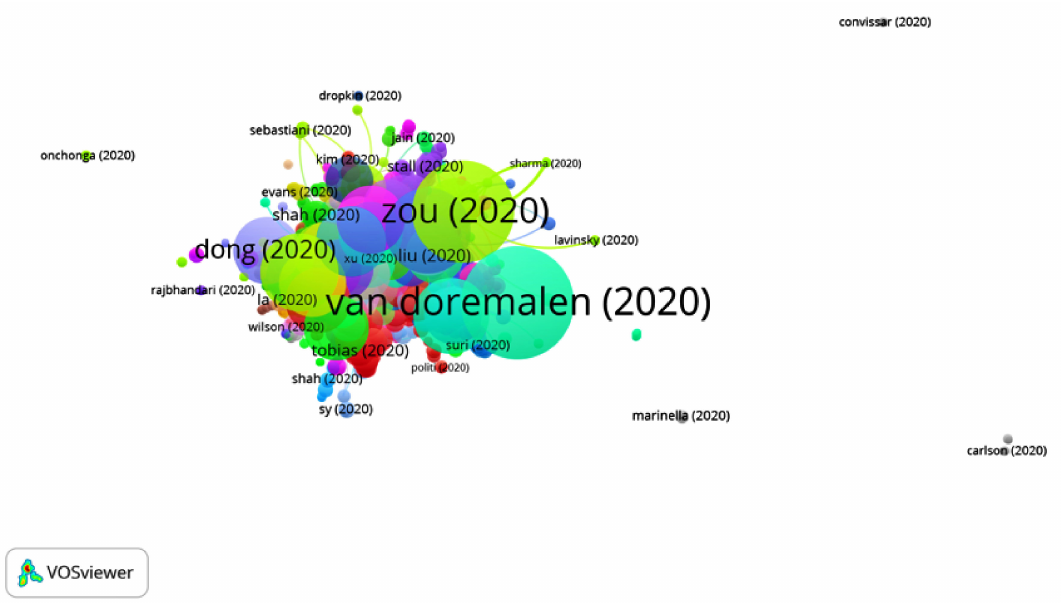
Figure 8. Citation network for Group